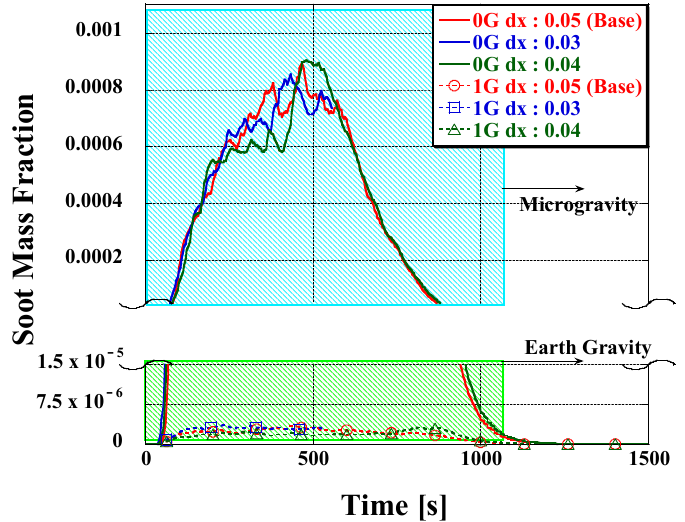
Figure 4. Sensitivity analysis of soot mass fraction calculated with different sizes of the mesh cell.